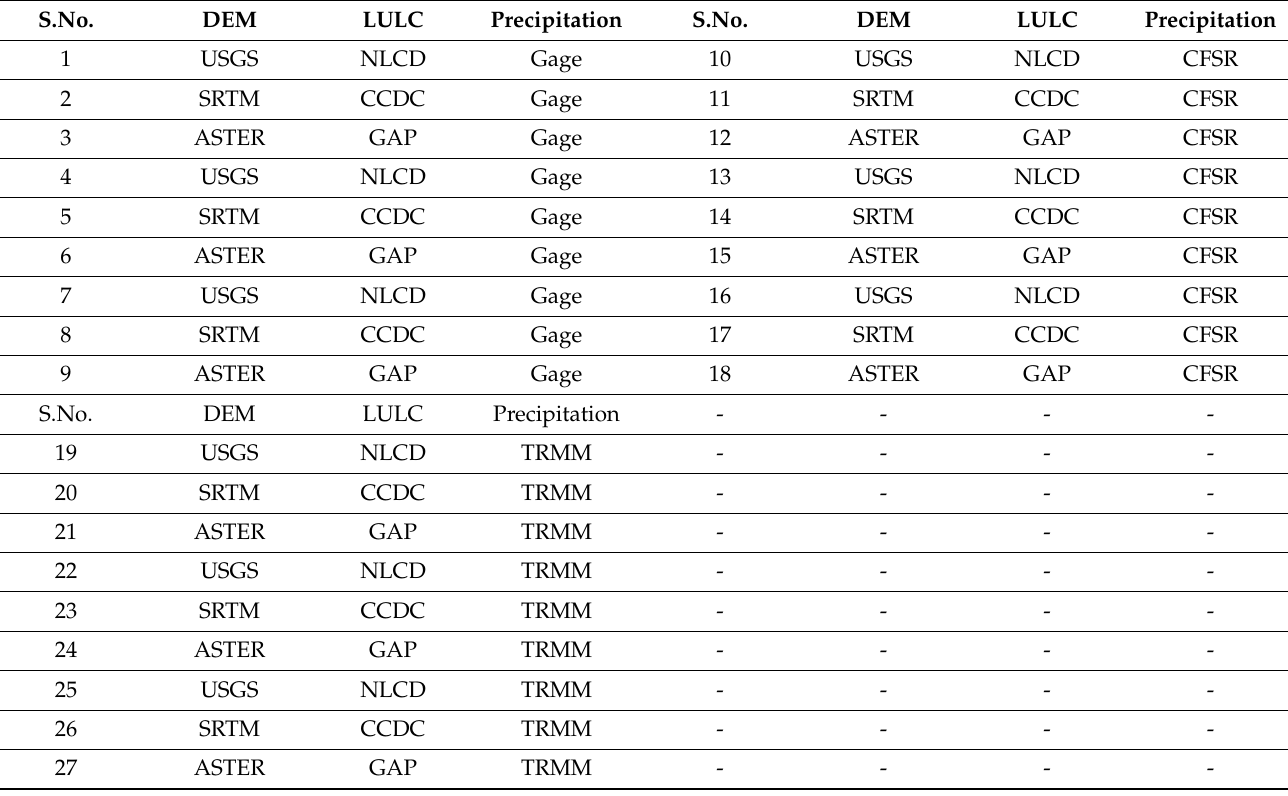
Table 3. List of input model combinations used in the